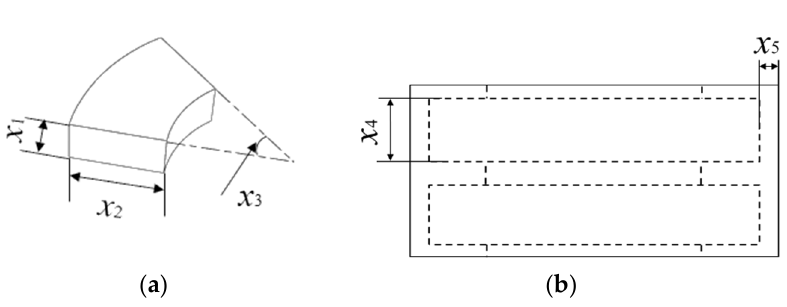
Figure 9. Variable parameter structure diagram: ( a ) Dimension diagram of kinetic; ( b ) Dimension diagram of stator.